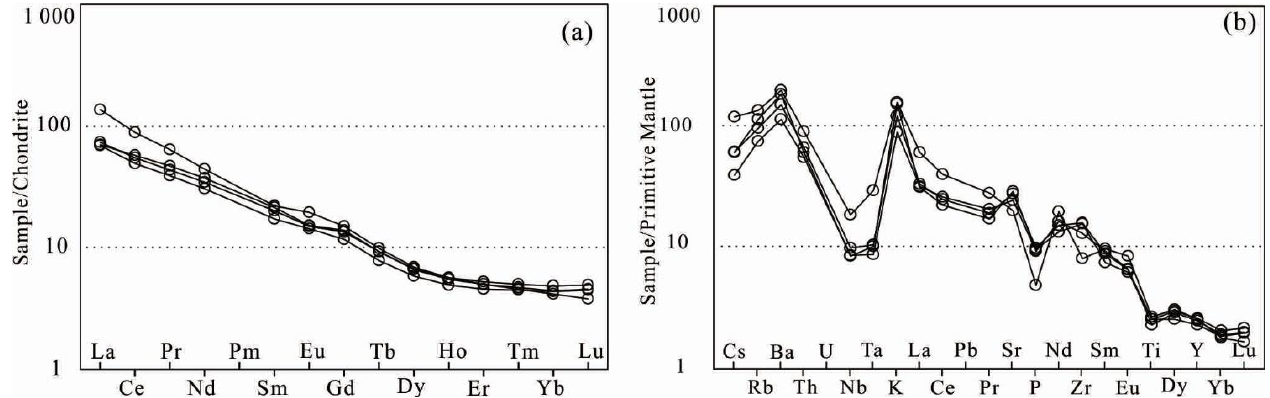
Figure 5. Chondrite normalized rare earth element pattern diagram (( a ), after reference [22]) and primitive mantle normalized spider diagram (( b ), after reference [23]) of quartz monzonites from the Jinling area, the western Shandong province.